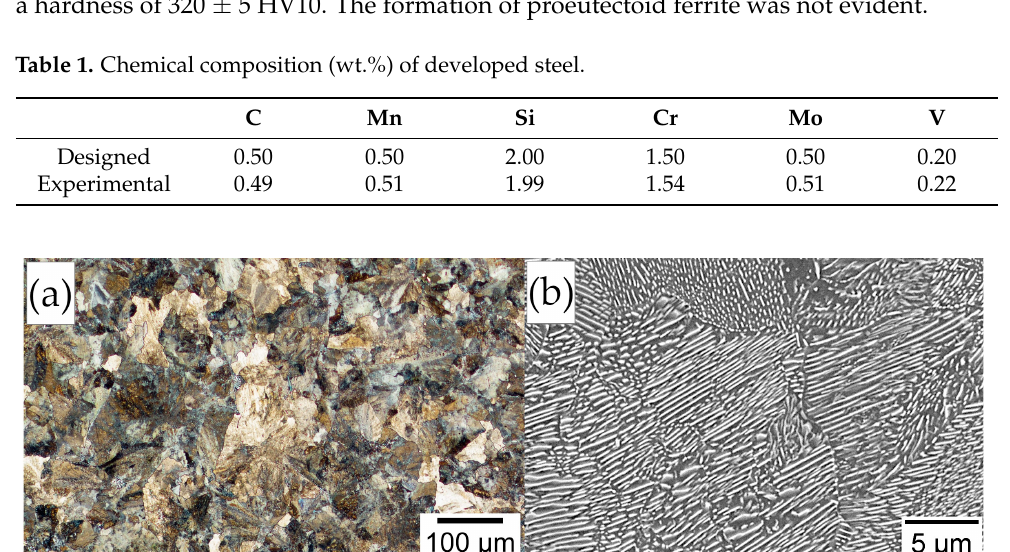
Figure 4. ( a ) Calculated fraction of carbide phases as a function of temperature of steel 0.5C-2.0Si-